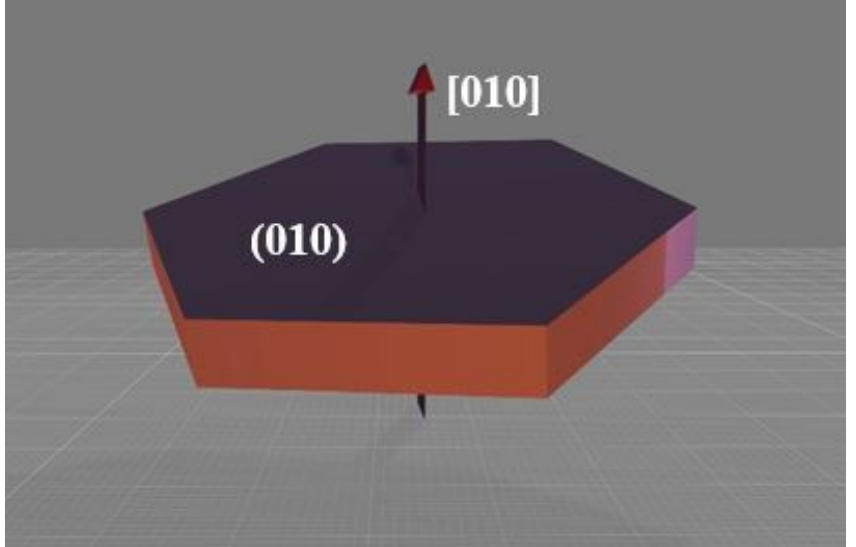
Figure 9. Direction of the particles’ channel [010].